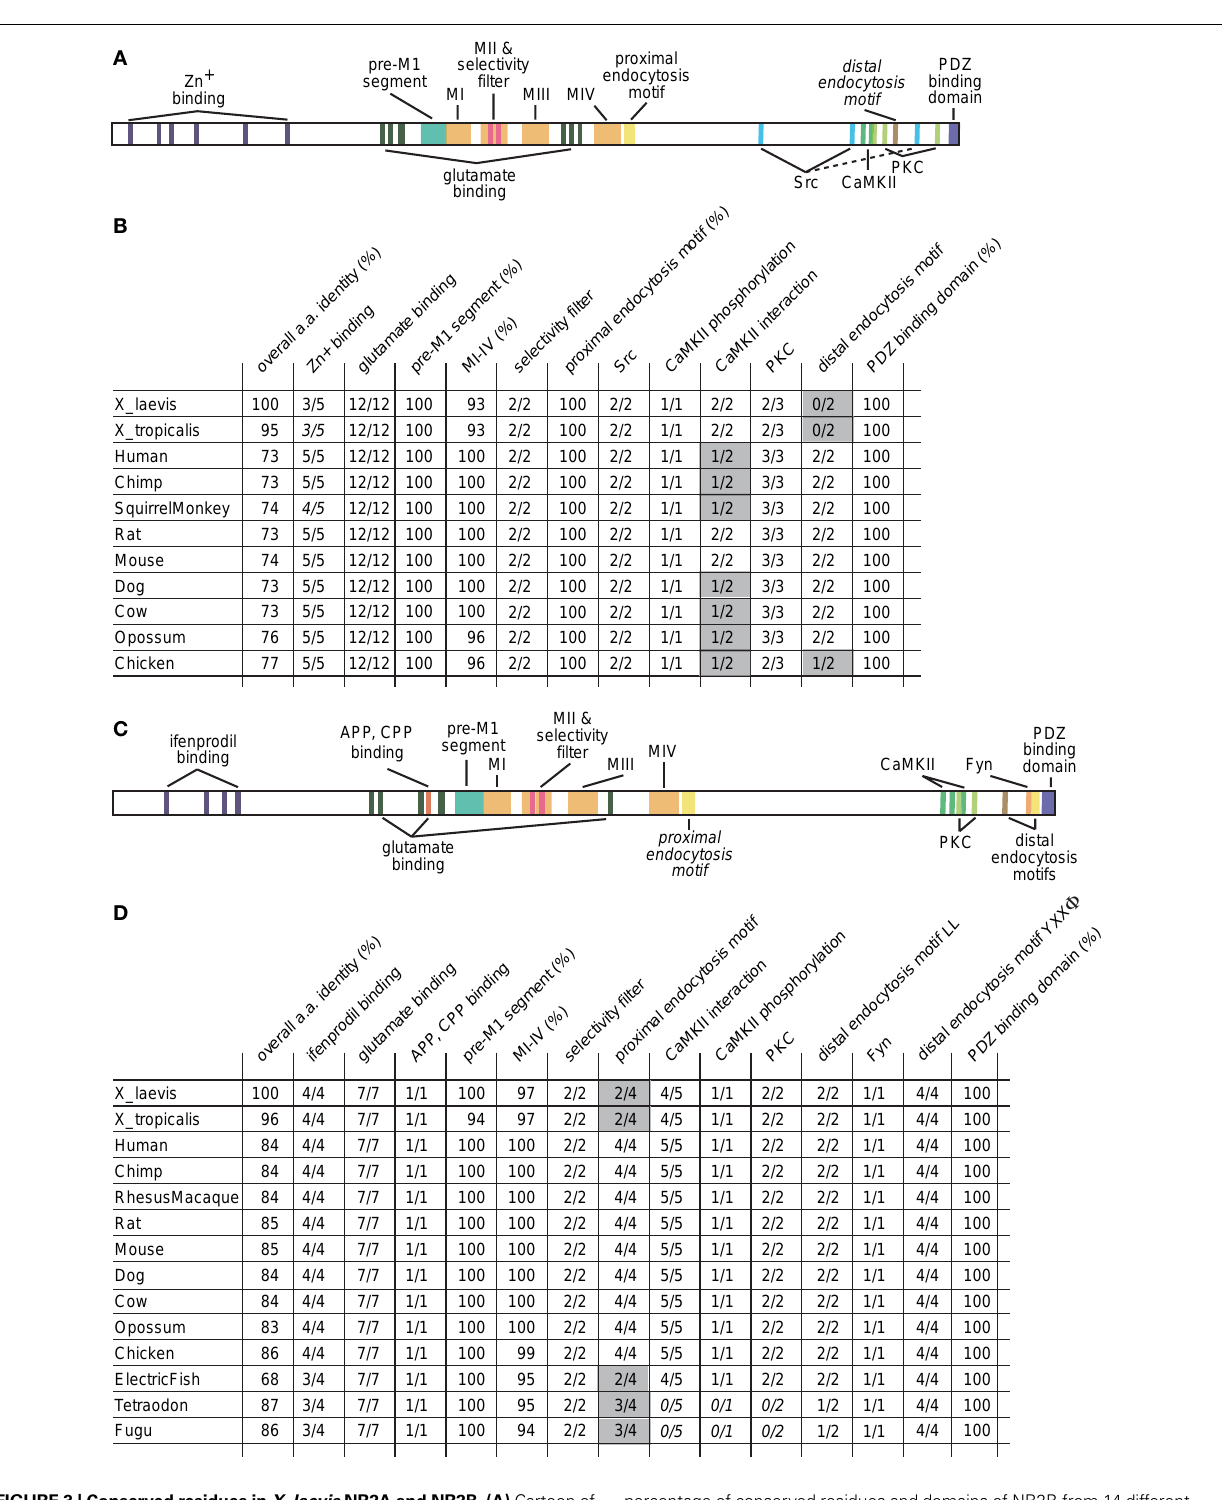
percentage of conserved residues and domains of NR2B from 14 different species. The overall amino acid identity was determined in comparison to the X. laevis NR2B protein. The number or percentage of conserved residues was determined in comparison to the sequence of the species where they were fi rst characterized (mostly rat). Functional sites that are not conserved between all species are highlighted in